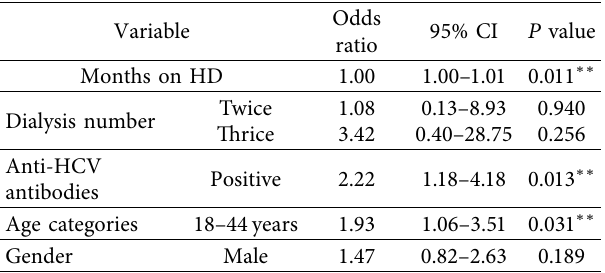
Table 5: Multivariate model for association of covariates with hemoglobin